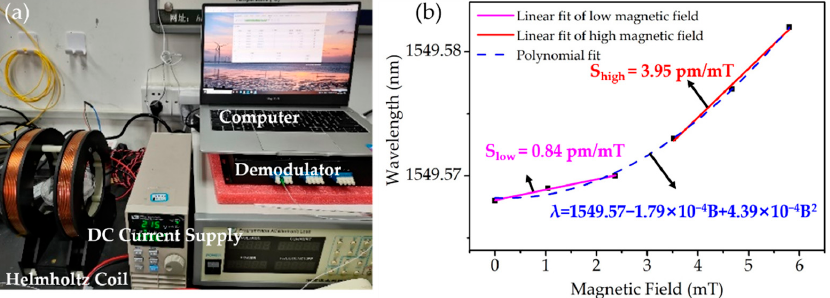
Figure 3. ( a ) Experimental system setup for DC magnetic field sensing. ( b ) Bragg wavelength shift of the HAFBG as a function of DC magnetic field intensity. the HAFBG as a function of DC magnetic field